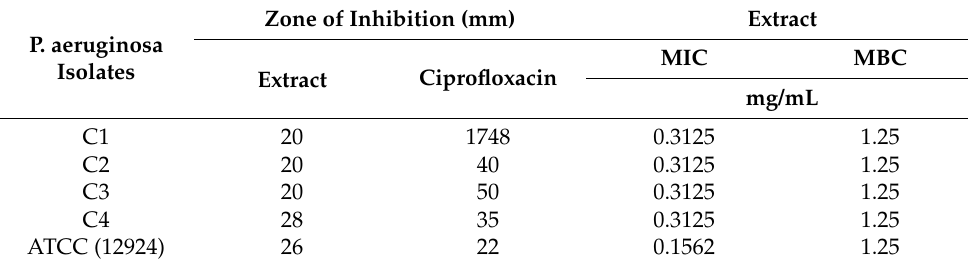
Table 3. Antimicrobial susceptibility, minimum inhibitory concentration (MIC), and minimal bac-